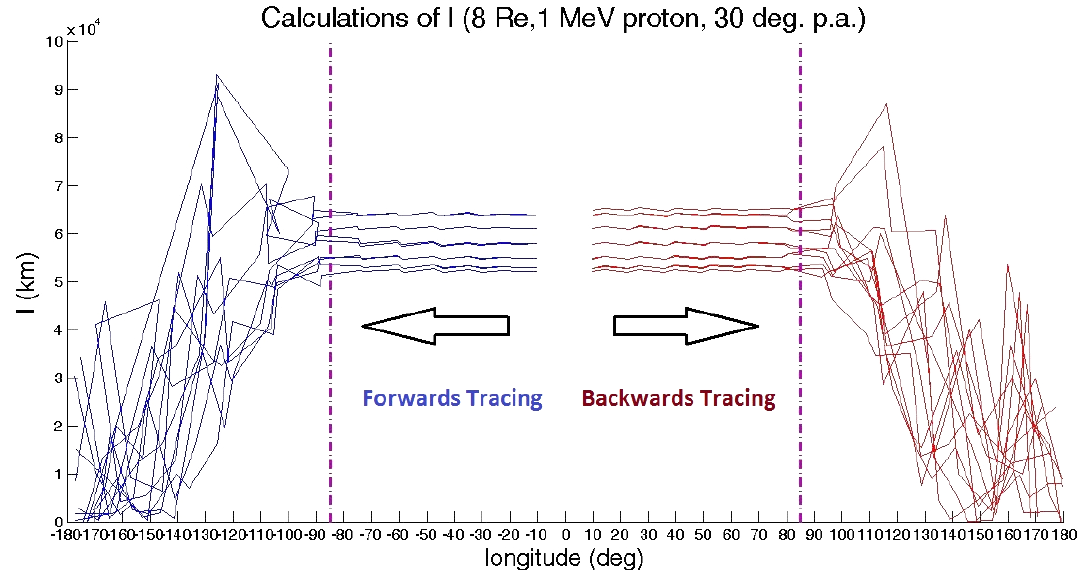
Figure 10. I as a function of the particle’s azimuth angle for the case 1MeV protons starting at GSM coordinates [8, 0, 0] (in R E ) with initial pitch angles of 30 ◦ , and initial gyrophases of 0–330 ◦ (30 ◦ step). Particles propagating forwards in time are shown in blue, while those propagating backwards are shown in red.